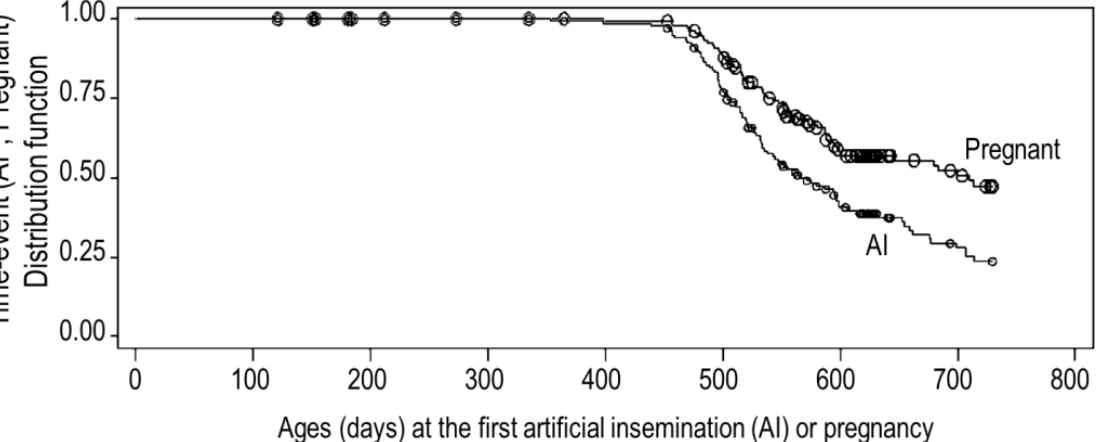
Figure 2. Kaplan–Meier distribution function of ages at the first artificial insemination (AI) and pregnancy of the bovine respiratory disease (BRD) calves.